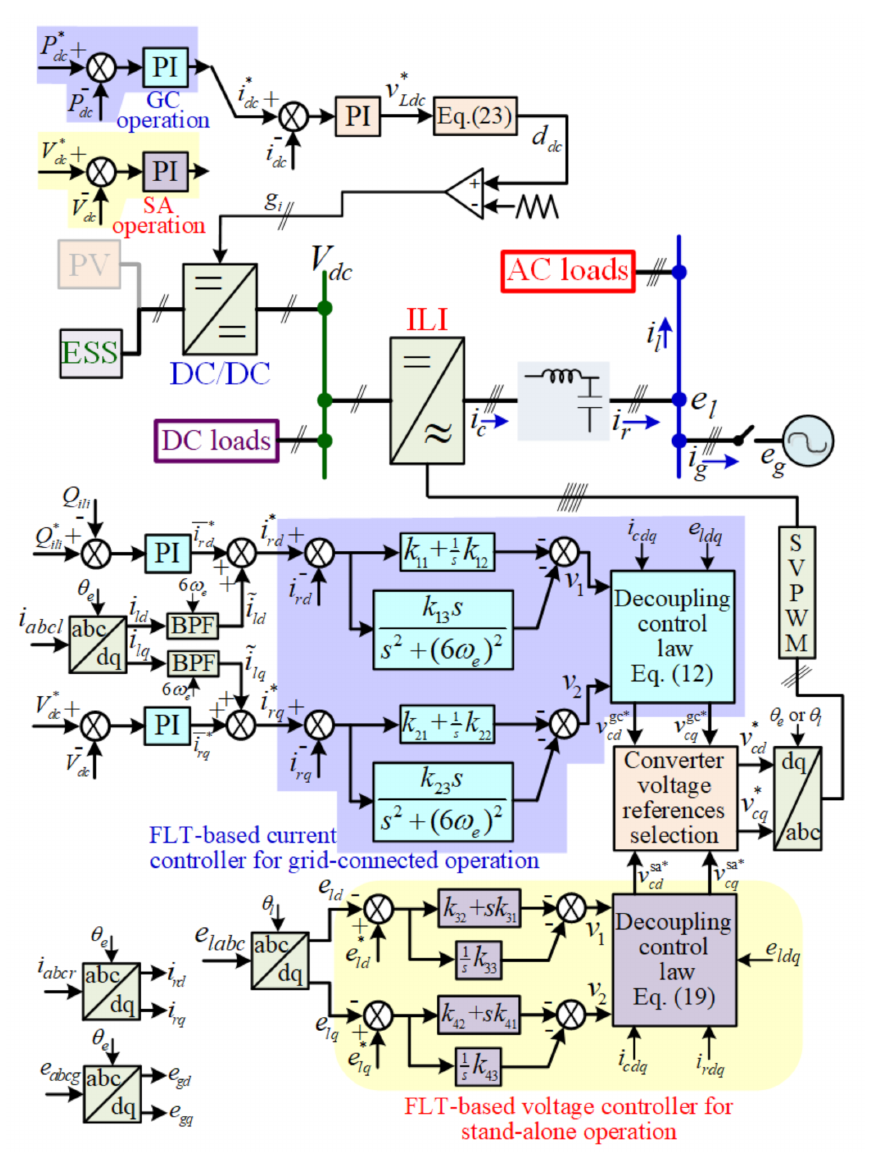
Figure 2. Control block diagram of the ILI and DC/DC converter in microgrid under both operation